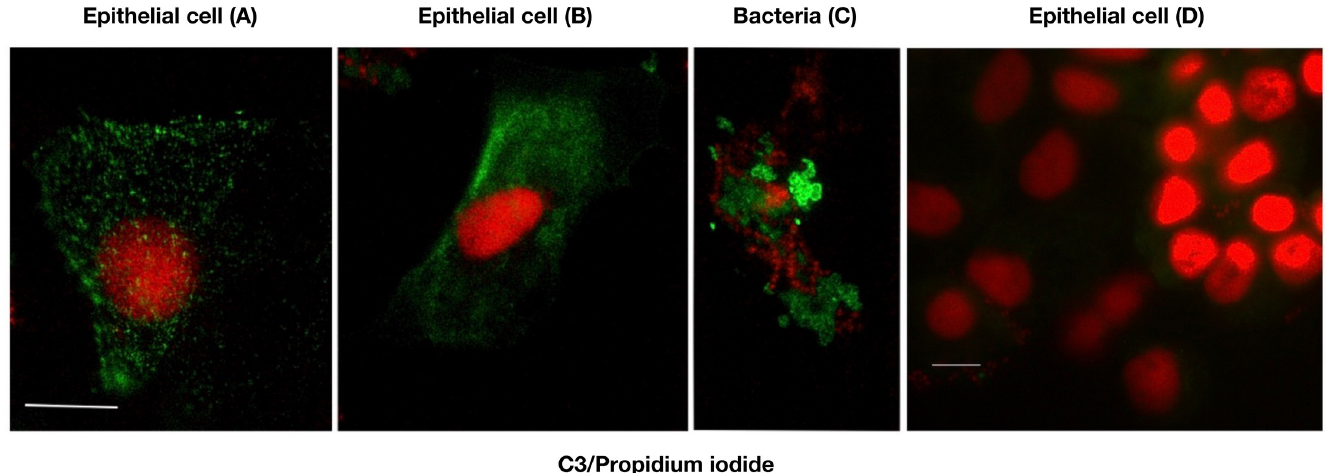
Fig 6. Immunofluorescence staining of urinary sediment using mAb 3F7E2. Tubular epithelial cells contain intracellular granules with C3 ( A, B ). Bacteria present in the urinary sediment are veiled in C3a/C3 to some extent ( C ). The scale bar represents 10 μ m. Immunofluorescence staining of a urinary sediment of a patient without systemic inflammation and AKI served as control ( D) . The scale bar represents 10 μ m.